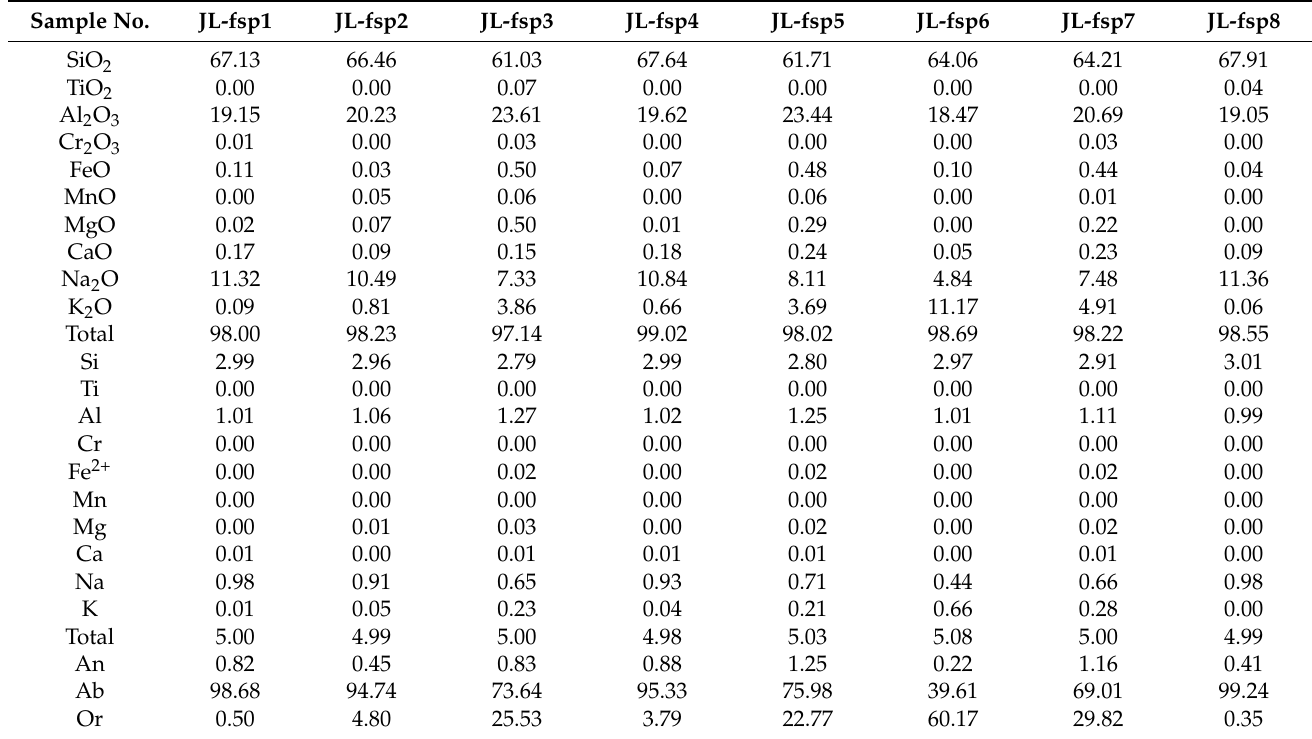
Table 1. EPMA data for magmatic feldspar from Jinling diorites.